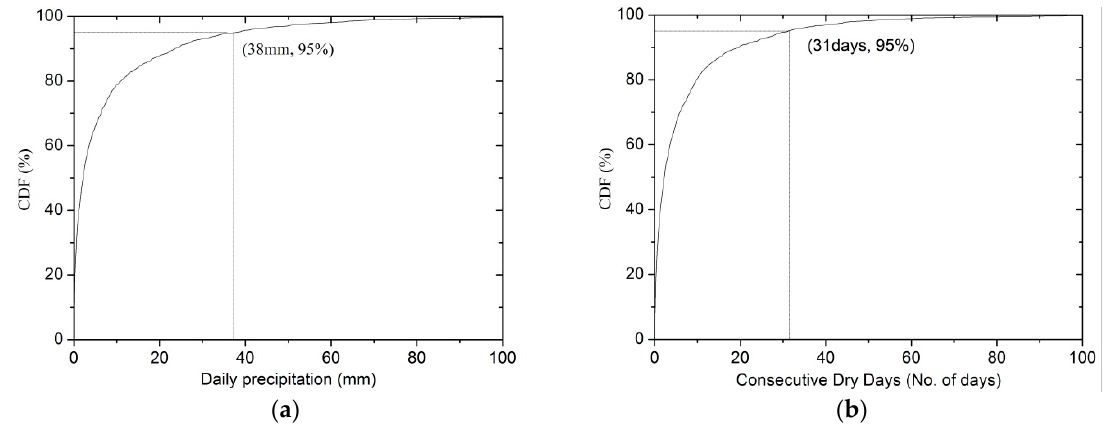
Figure 3. Threshold determination of ( a ) precipitation extreme and ( b ) drought extreme by the cumulative distribution function (CDF).